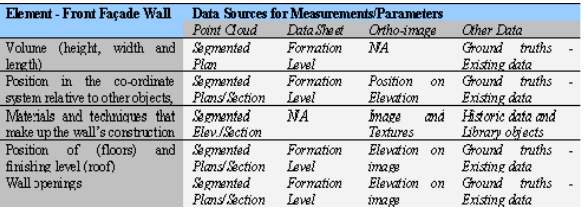
Table 1 Data Sources for Modelling Façade